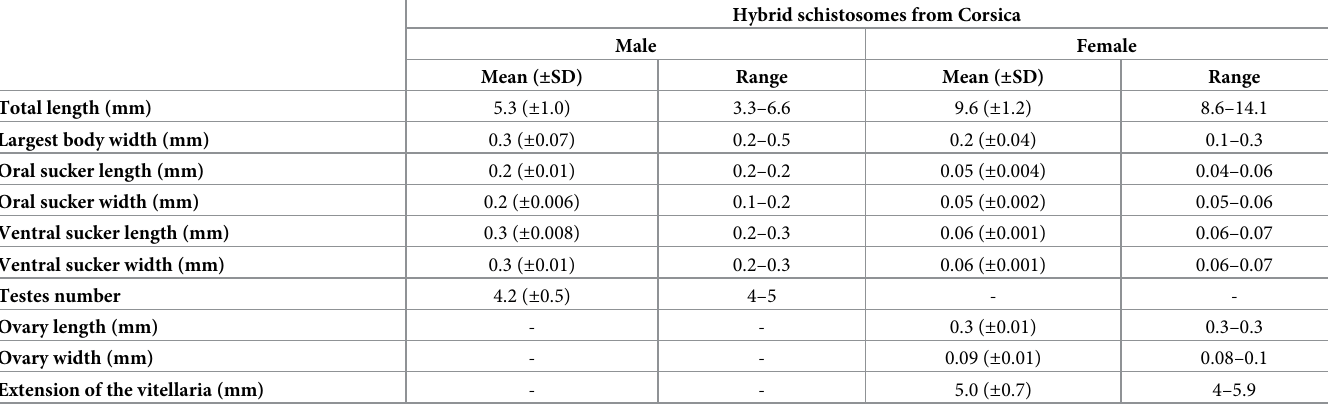
Table 1. Morphological measurements of the European male and female hybrid adult